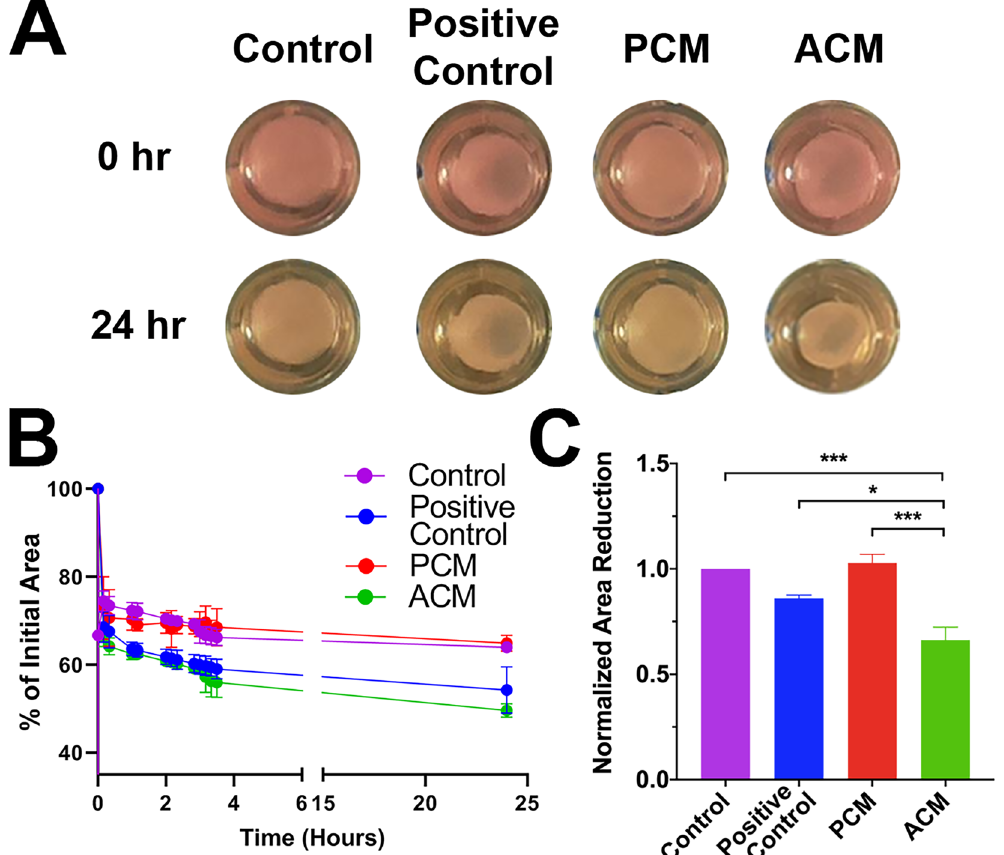
Figure 2. Adipocyte Conditioned Medium Promotes Fibrin Gel Compaction. ( A ) Representative images of fibroblast-seeded fibrin gels shortly after release and 24 hours later. Gels were cultured in control media, TGF- β 1 and AA supplemented media (positive control), pre-adipocyte conditioned media (PCM), or adipocyte conditioned media (ACM). ( B ) A representative experiment showing percent reduction in initial gel area ( i.e ., compaction) over time (mean ± SD, n = 3). ( C ) Fibrin gel compaction at 24 hours normalized by controls for n = 3 independent experiments, each with 3 sample replicates per group. Data is presented as mean ± SEM.